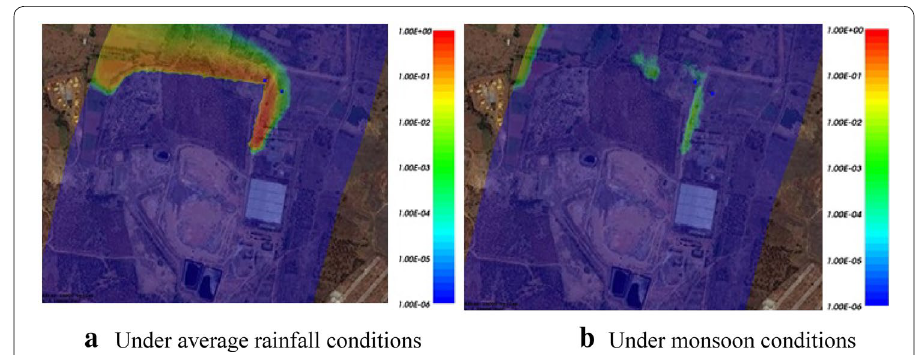
Fig. 12 Normalized concentration of zinc in the sandy layer